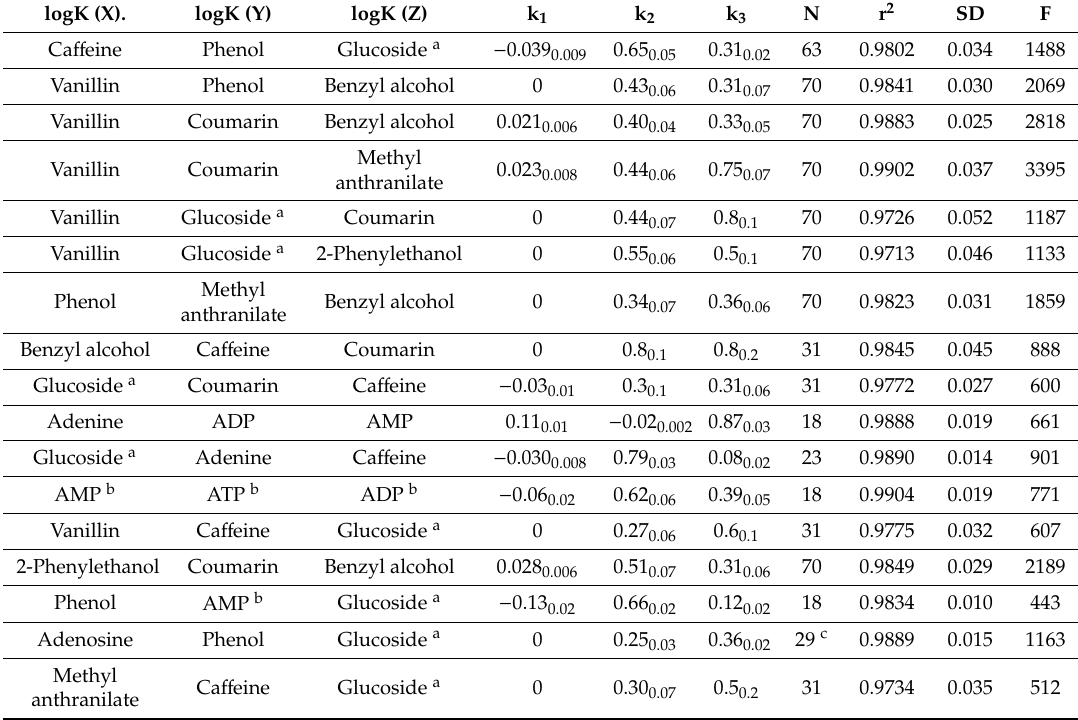
Table 1. Coefficients and statistical characteristics of linear relationships (k 1 , k 2 , and k 3 are the constants in equation (1); N is the number of solutes examined; r 2 is the correlation coefficient; SD is the standard deviation; and F is the ratio of variance) between logarithms of partition coefficients for various organic compounds in aqueous two-phase systems (ATPSs) of different ionic compositions (for raw data see in Table S1). logK